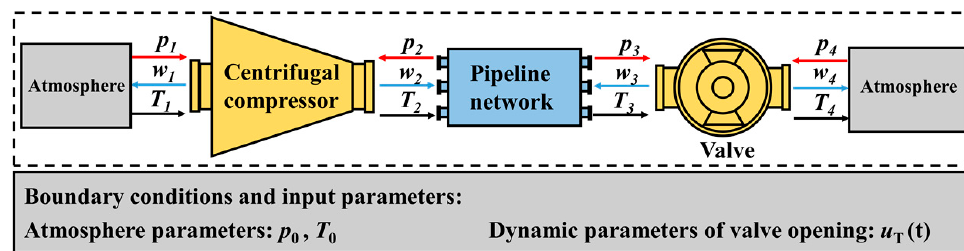
Figure 8. The relative error of simulation and experimental results. ( a ) The relative error of inlet pressure, ( b ) the relative error of outlet pressure, ( c ) the relative error of inlet temperature, ( d ) the relative error of outlet temperature.